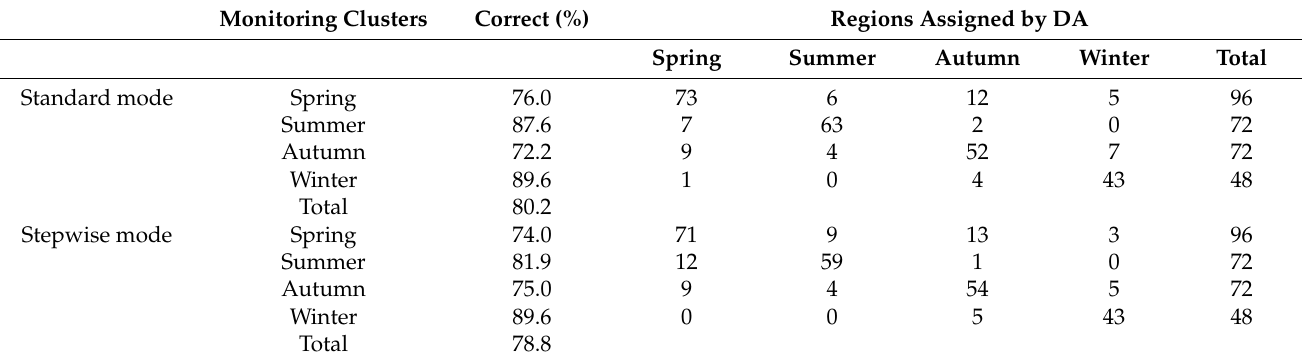
Table 6. Classification matrix for the discriminant analysis of temporal